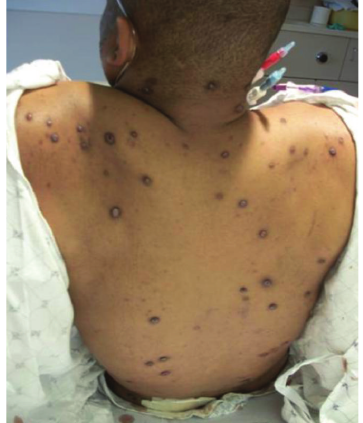
Figure 1: Hyperpigmented nodules with hemorrhagic crusting on the back.